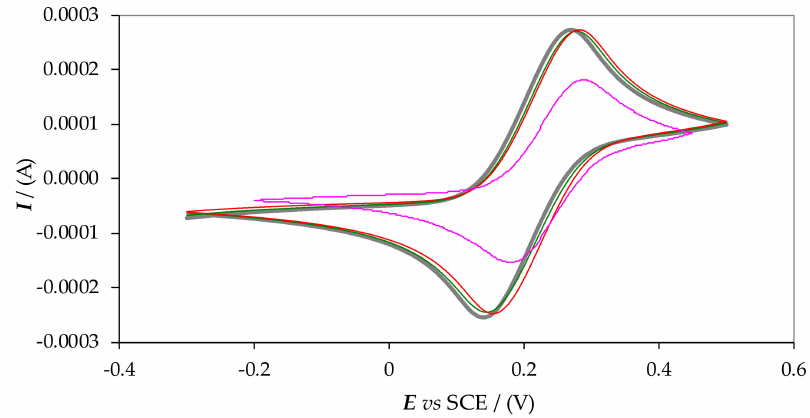
Figure 11. CV patterns recorded at 0.05 V s –1 for the achiral couple K 3 [Fe(CN) 6 ] + K 4 [Fe(CN) 6 ] (each of them 2.5 mM in 0.4 M KCl): on a bare Indium Tin Oxide (ITO) electrode without the application of an external magnet (grey line); on bare ITO as a function of the magnetic field orientation (green line for north pole, red line for south pole); on hybrid ITO | oligo-( S )-Naph 2 T 4 electrode (pink line) without the external